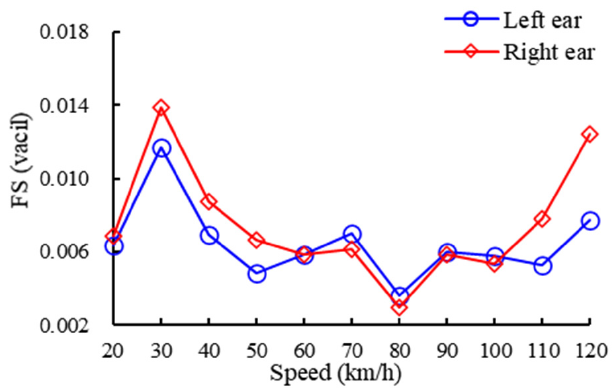
Figure 9. Interior noise fluctuation strength (FS) in the EV as a function of the vehicle’s speed.